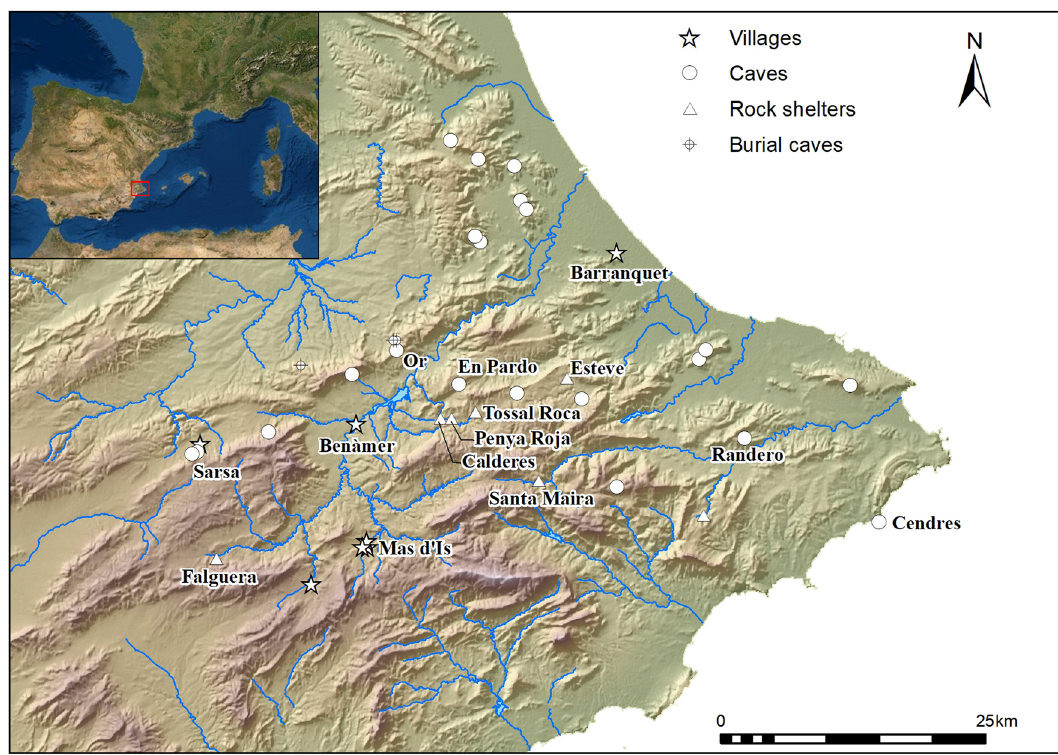
Figure 1: Location of main sites mentioned in the